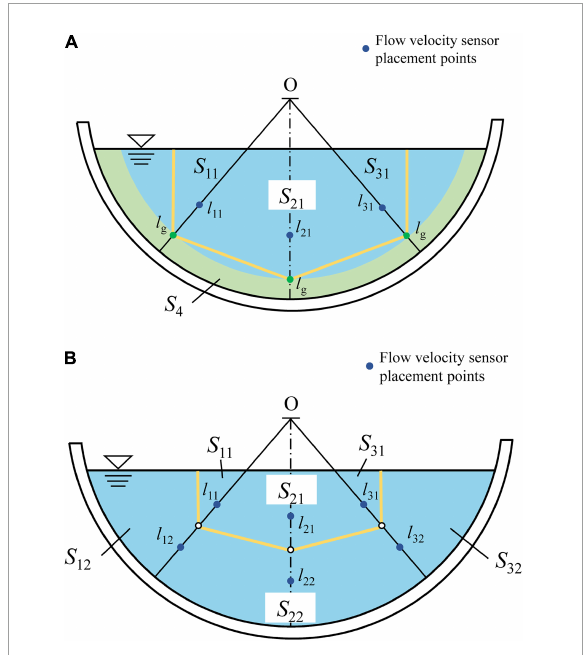
FIGURE9 Diagram of estimating discharge with 3-measuring-lines. The positions of l 11 , l 12 ... l 32 are determined by Eqs. (11) and (21), and S 11 , S 21 ... S 4 are the areas of the polygon. (A) vegetated channel, (B) smooth